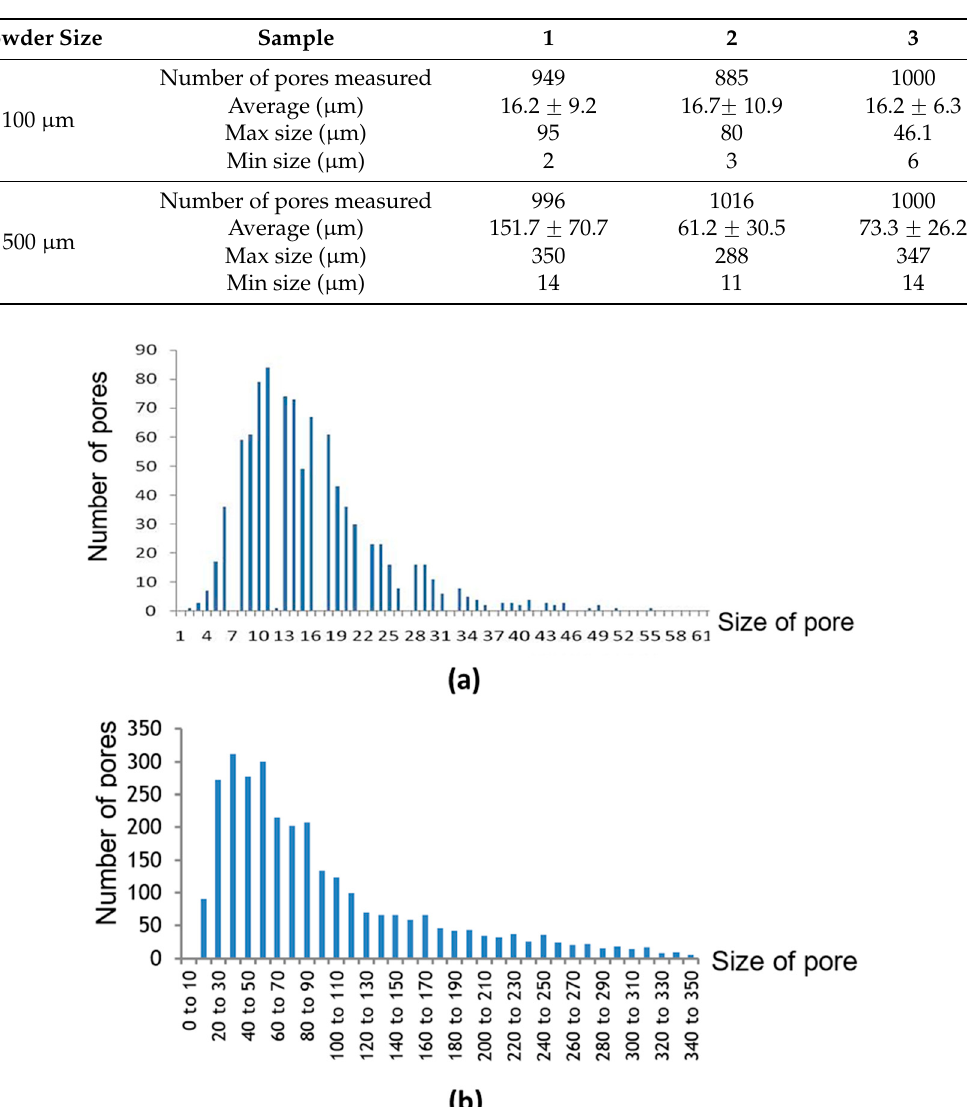
Table 3. Distribution of pore size of three membranes made from 100 µ m and 500 µ m powder.